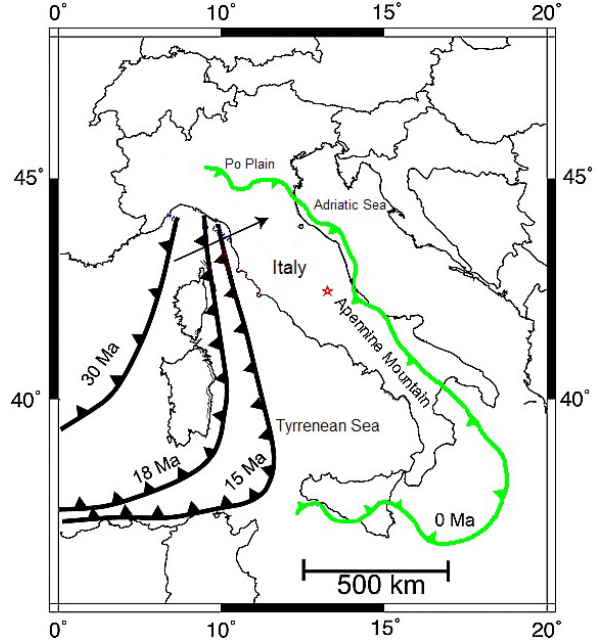
Figure 1 The location and the main plates of the Abruzzo M6.3 Earthquake on April 6, 2009 Note: the is the epicenter, the is the main thrust fault. (Benoit et al., 2011).